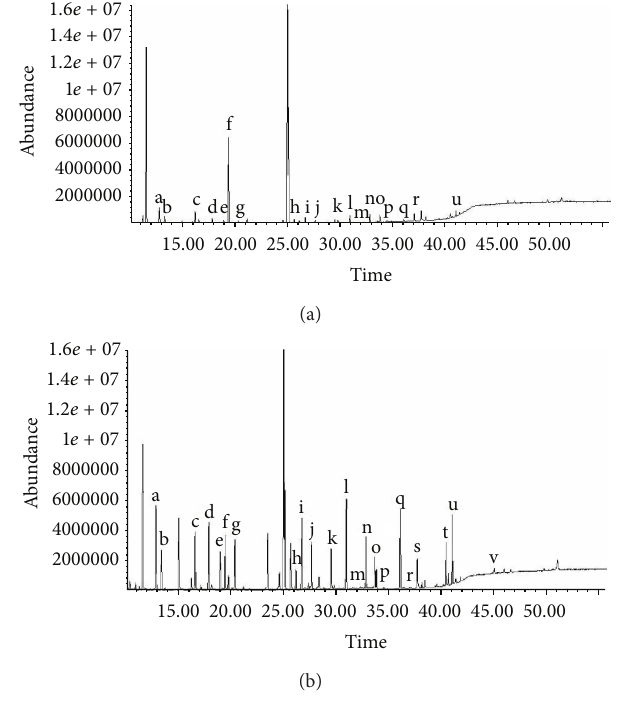
Figure 2: Chromatogram of free amino acids detected in fresh loin (a) and dry-cured ham (b) samples. Alanine (a), glycine (b), valine (c), leucine (d), isoleucine (e), norleucine (f, internal standard), proline (g), methionine (h), serine (i), threonine (j), phenylalanine (k), aspartic acid (l), hydroxyproline (m), cystine (n), glutamic acid (o), asparagine (p), lysine (q), glutamine (r), arginine (s), histidine (t), tyrosine (u), and tryptophan